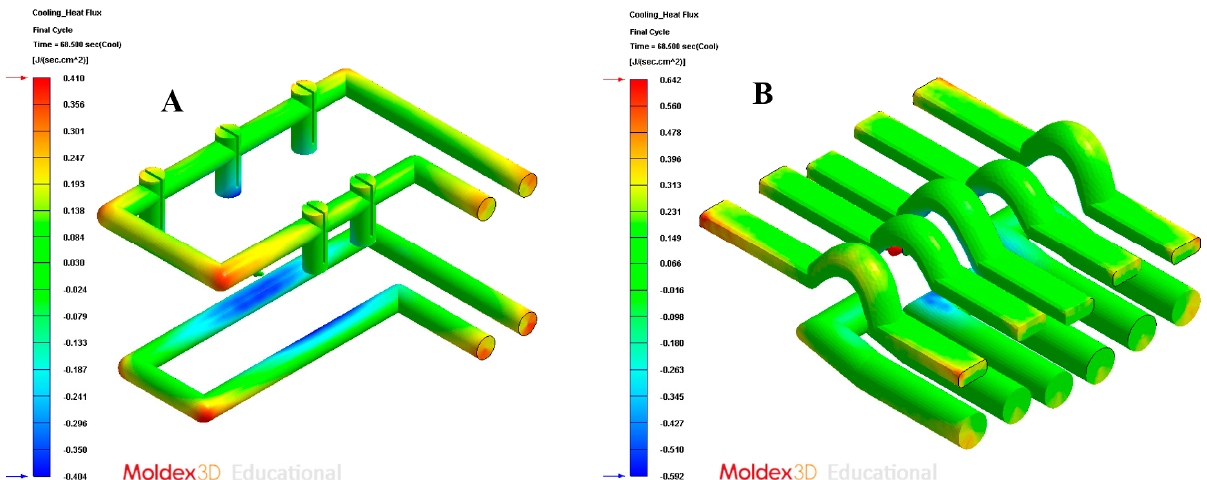
Figure 25. Cooling heat flux. ( A ) Traditional cooling; ( B ) conformal cooling.